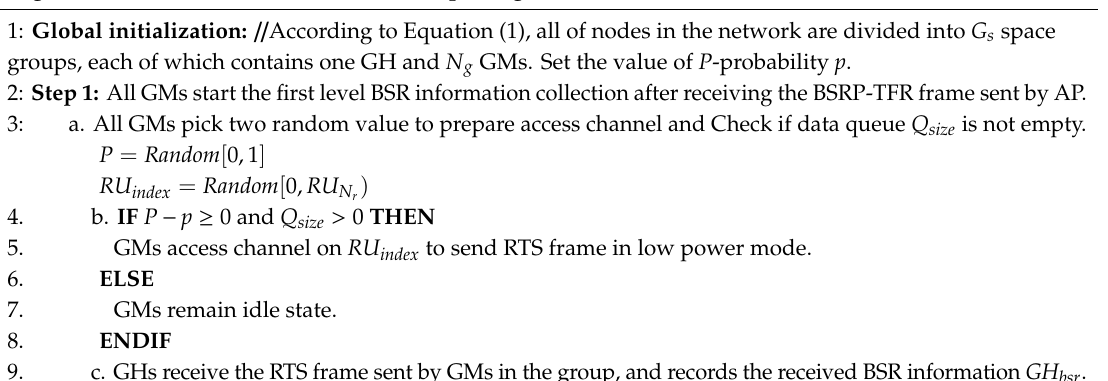
Algorithm 1: Two level BSR information reporting